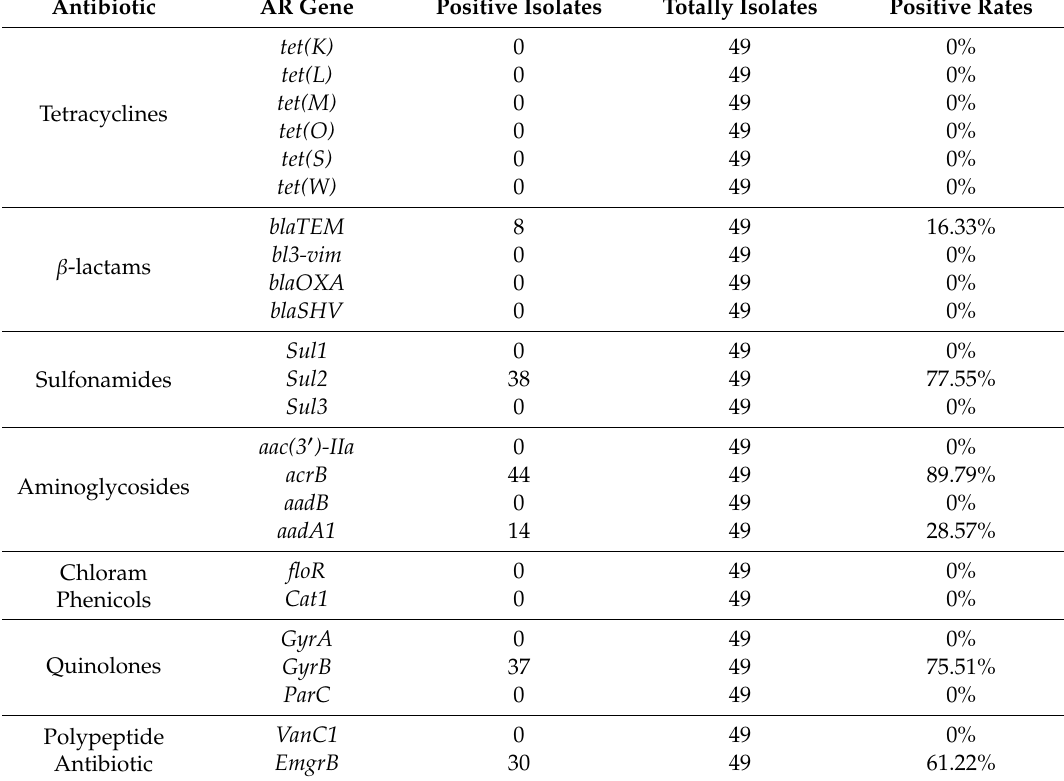
Table 4. Detection rate of 26 drug resistance genes in 49 strains of T.